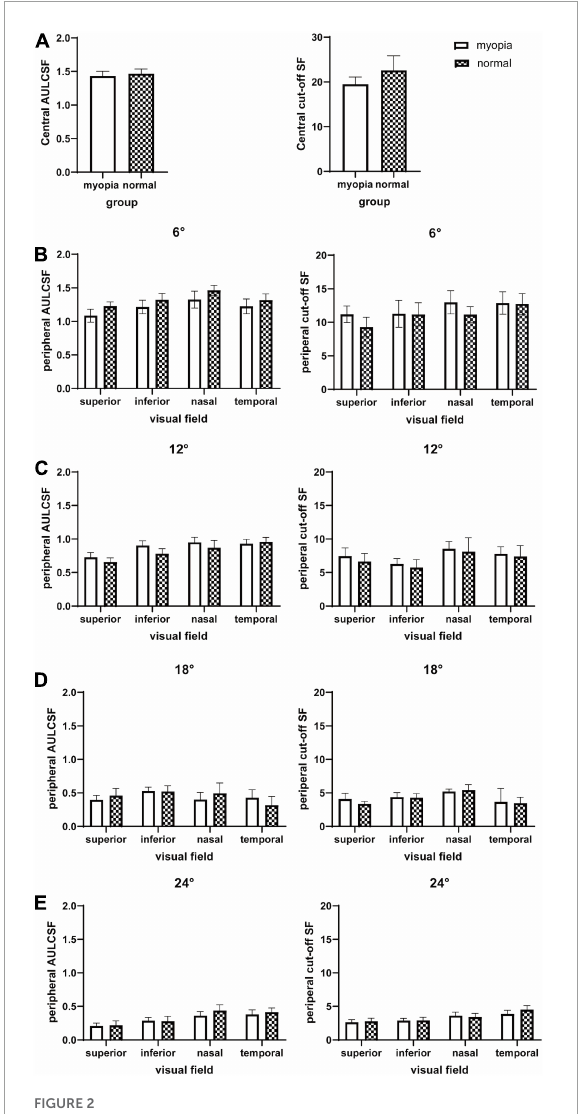
FIGURE2 AULCSF and cut-off SF at the fovea and 16 peripheral locations in the visual field. (A) Central, (B) peripheral 6 ◦ , (C) peripheral 12 ◦ , (D) peripheral 18 ◦ , and (E) peripheral 24 ◦ . The plot shows the mean and 95% confidence limits. The white columns denote the myopia group and the shaded columns denote the normal group.